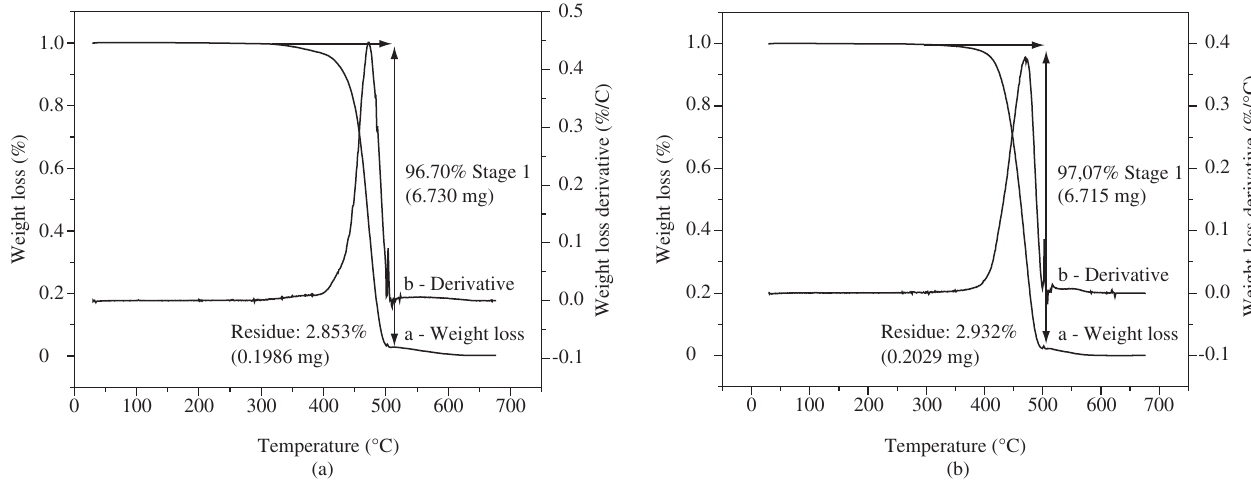
Figure 2. a) TG curve of LDPE CBC sample; and b) TG curve of LDPE CBTS sample.